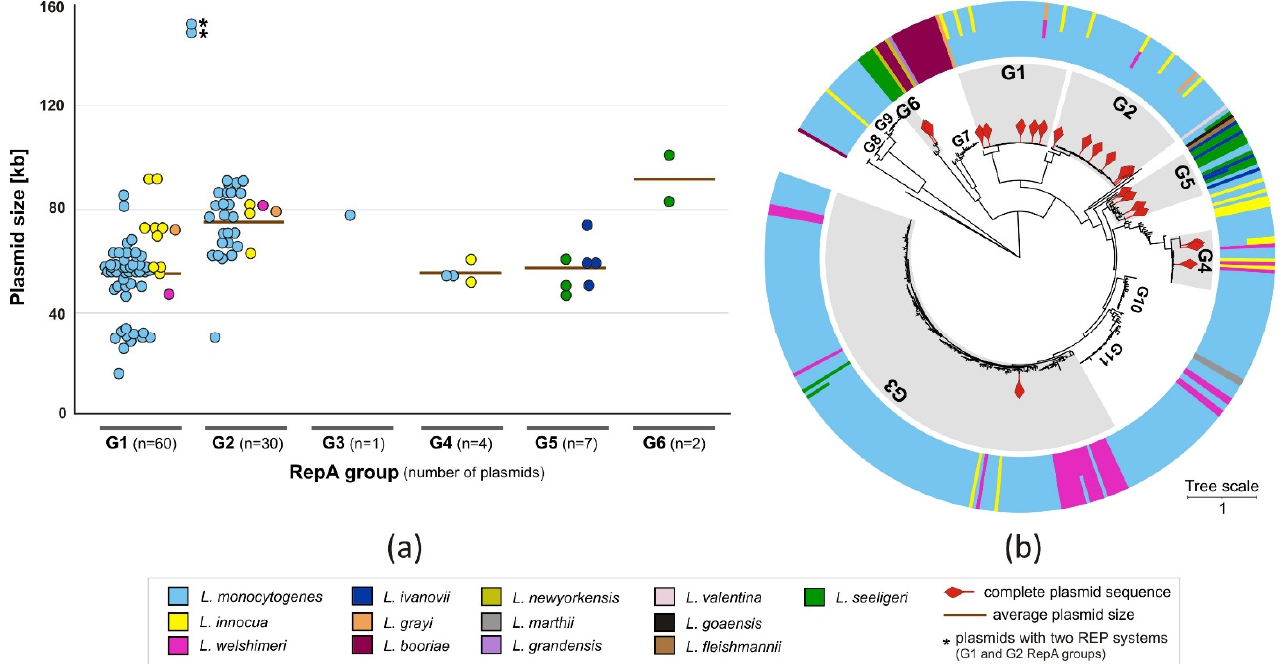
Figure 2. Diversity of the Listeria spp. repA ‐ family plasmids. ( a ) Size distribution of the repA ‐ family plasmids analyzed in this study, grouped according to the RepA phylogenetic clusters. G1–G6 indicate RepA groups. ( b ) Phylogenetic tree of related RepA proteins found in Listeria spp. genomes (GenBank); the gray areas indicate proteins belonging to the G1–G6 RepA groups, while the outer ring presents Listeria species encoding the RepA proteins. Additional main phylogenetic RepA groups, for which no complete Listeria spp. plasmid sequences are yet known, were named G7–G11.